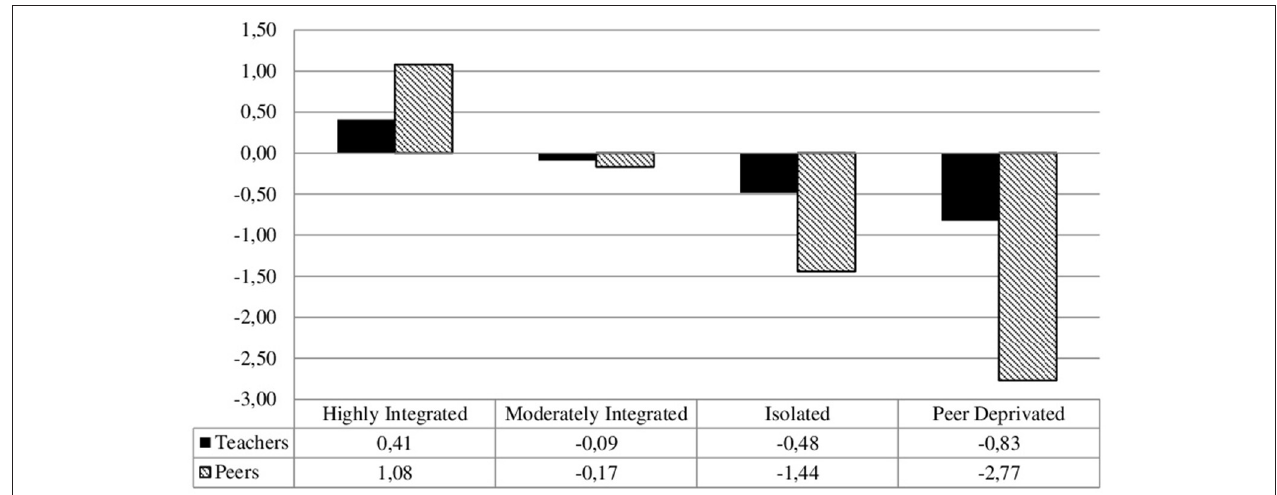
FIGURE 2 | Social integration: teachers and peers (z-standardized means). The integration profiles were calculated based on the means: SD within each profile are for teacher integration (SD = 0.89) and peer integration (SD = 0.12).